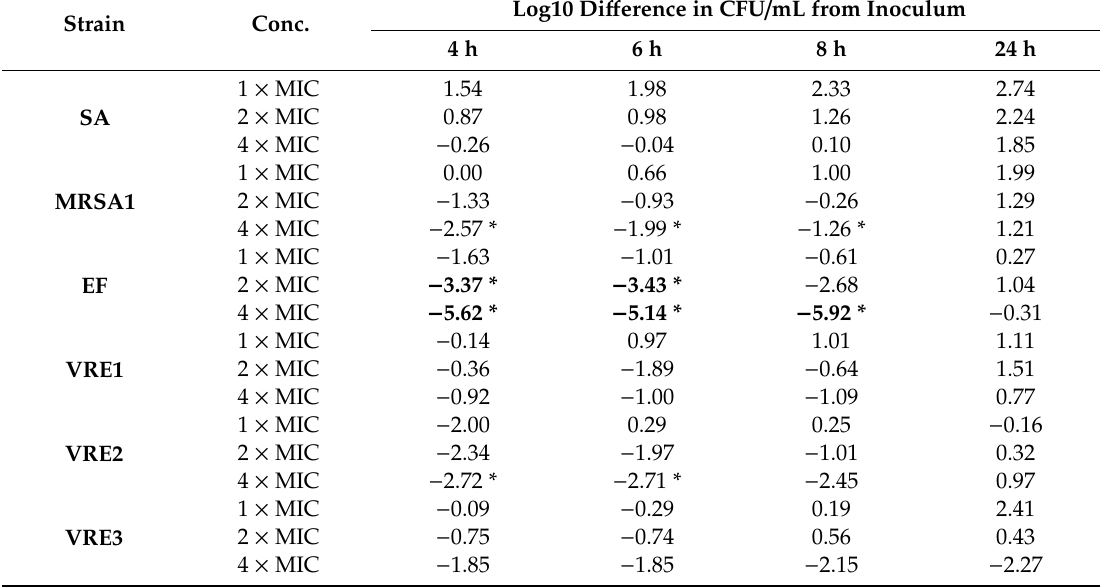
Table 4. Change in viable counts (log10 colony-forming unit (CFU) / mL) of staphylococci and enterococci strains following incubation for 24 h with compound 1g . Bactericidal e ff ect is expressed in bold. Log10 Di ff erence in CFU / mL from Strain Conc.